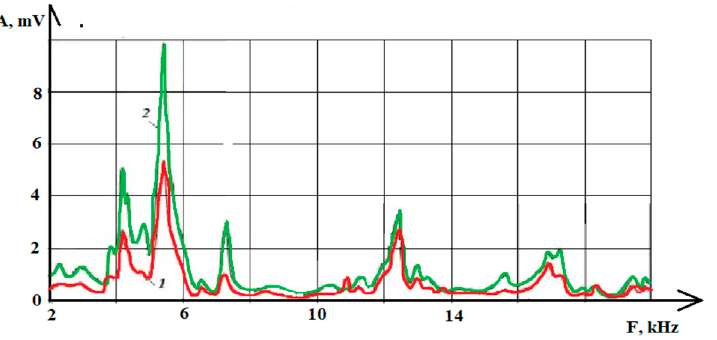
Figure 13. The spectra of VA signals during EDM processing at different power outputs of the energy impact when WC-6%Co cutting.